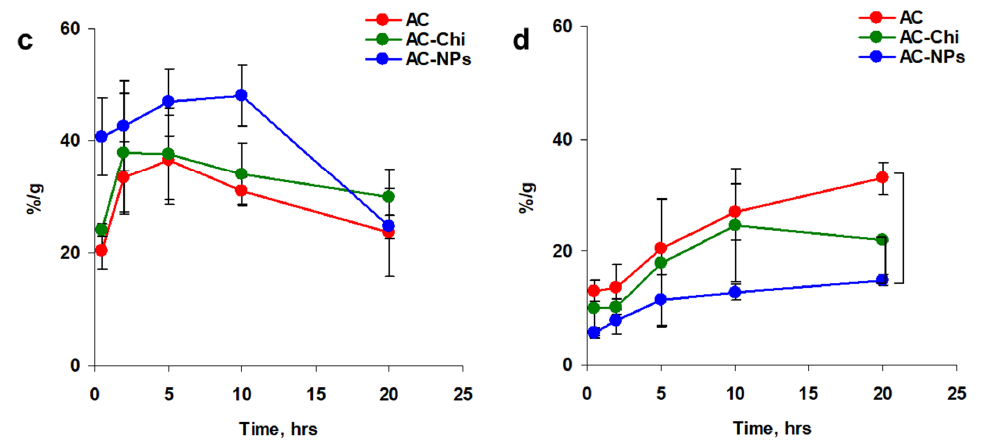
Figure 5. Dynamics of furano-allocolchicinoid 2 preparation accumulation in different tissues. Mice were once IV injected with a comparable quantity of formulations. Percentage of rhodamine B per gram of tissue (%/g) in liver ( a ), spleen ( b ), lungs ( c ), and kidney ( d ) at different time post injection. Significant differences ( p < 0.05) are shown by